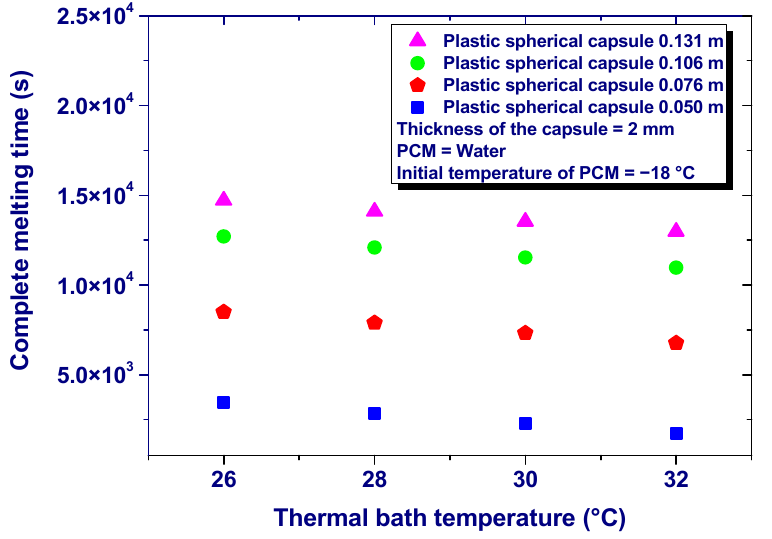
Figure 17. Impact of the dimension of the plastic spherical capsule on the complete melting time.